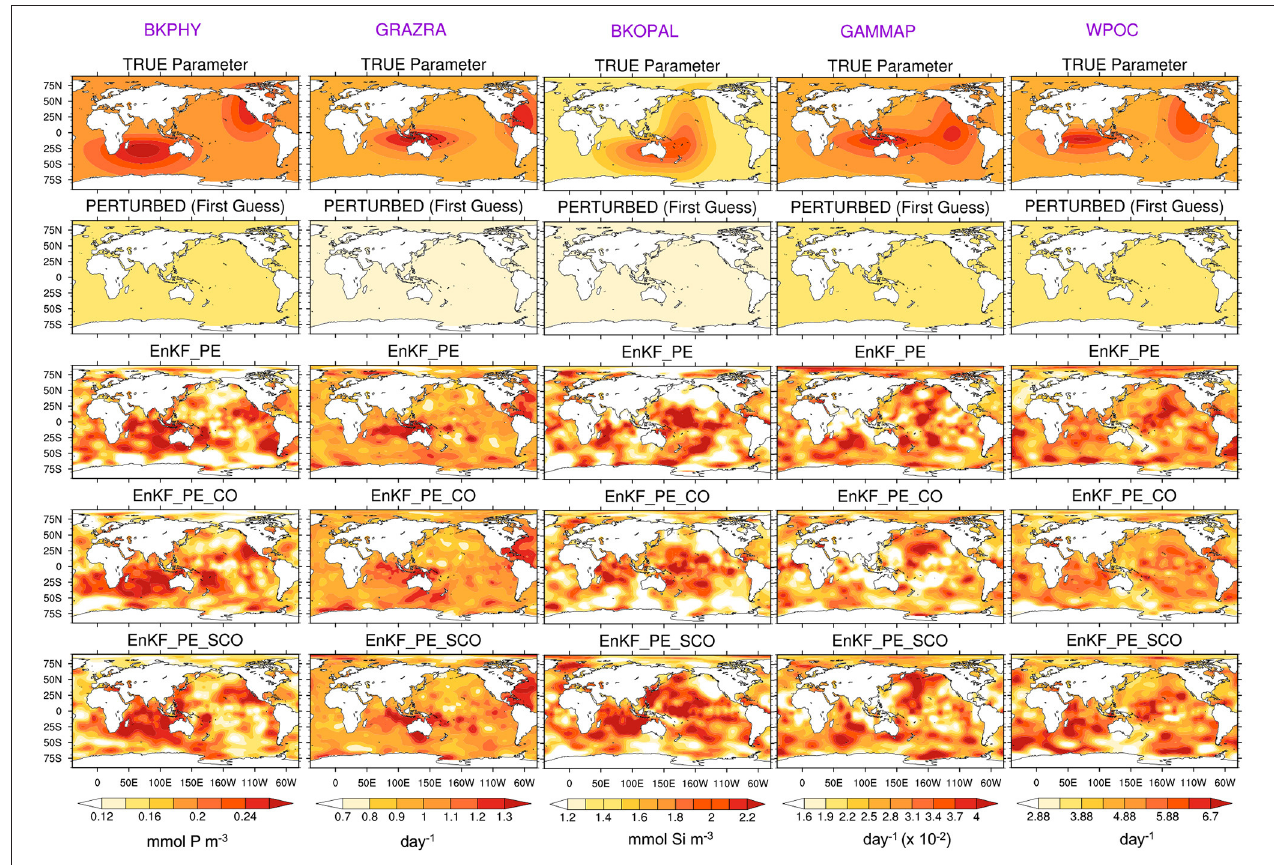
FIGURE 6 | True (row-one) and point wise ensemble mean of the perturbed (row-two) and estimated BGC parameters in December 1990 with assimilation of time-varying (row-three), climatological (row-four), and very sparse climatological (row-five) BGC surface observations in addition to time varying physics. Column-one to -five correspond to BKPHY, GRAZRA, BKOPAL, GAMMAP, and WPOC